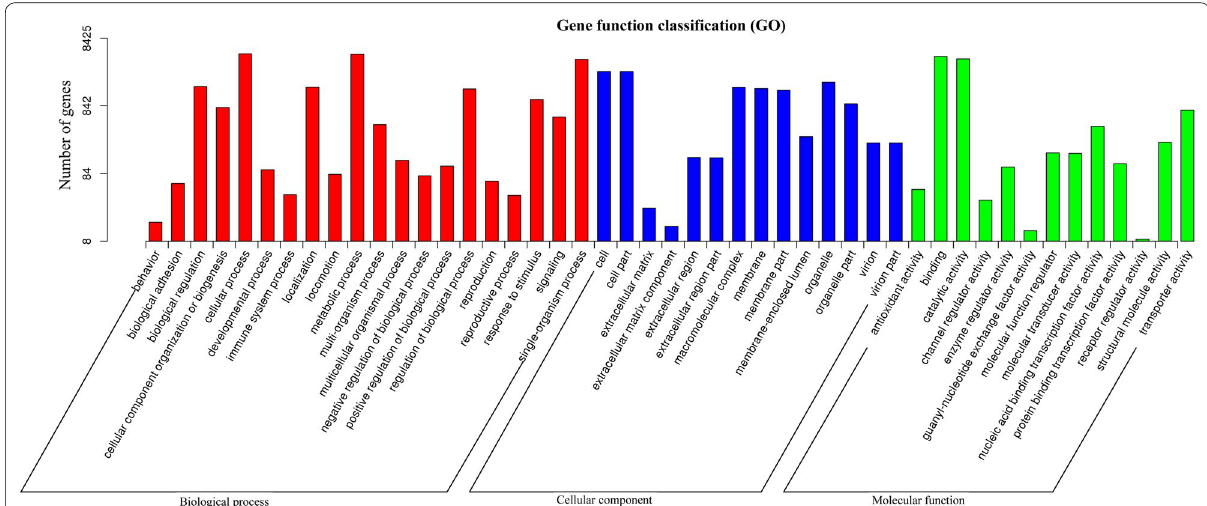
Fig. 2 GO annotation of the C. cladosporioides MD2 unigenes. The annotated unigenes were classified into cellular component, molecular